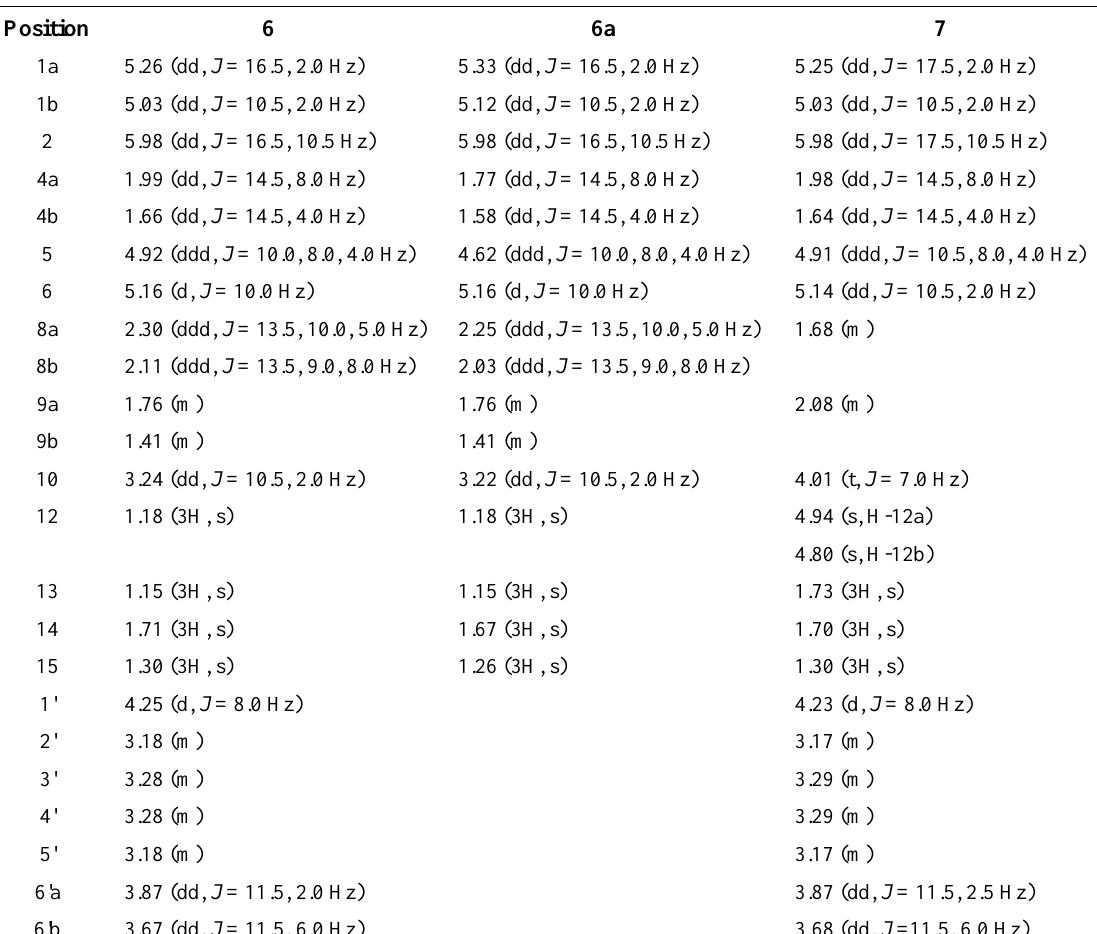
OD) spectral data of 6 , 6a and 7 3